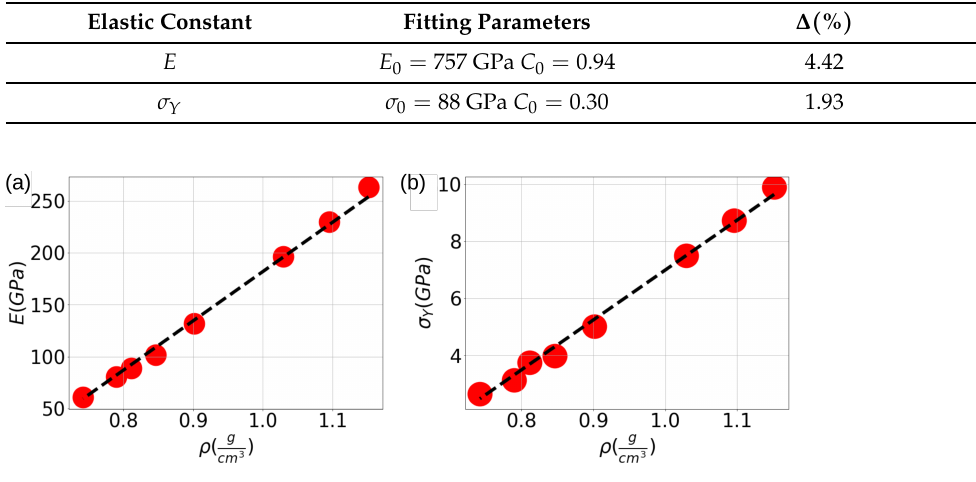
Figure 4. Comparison of ( a ). MD results (red points) with linear regression for Young Modulus ( a ) and Yield Stress ( b ) during the foam fracture process respecting density ρ